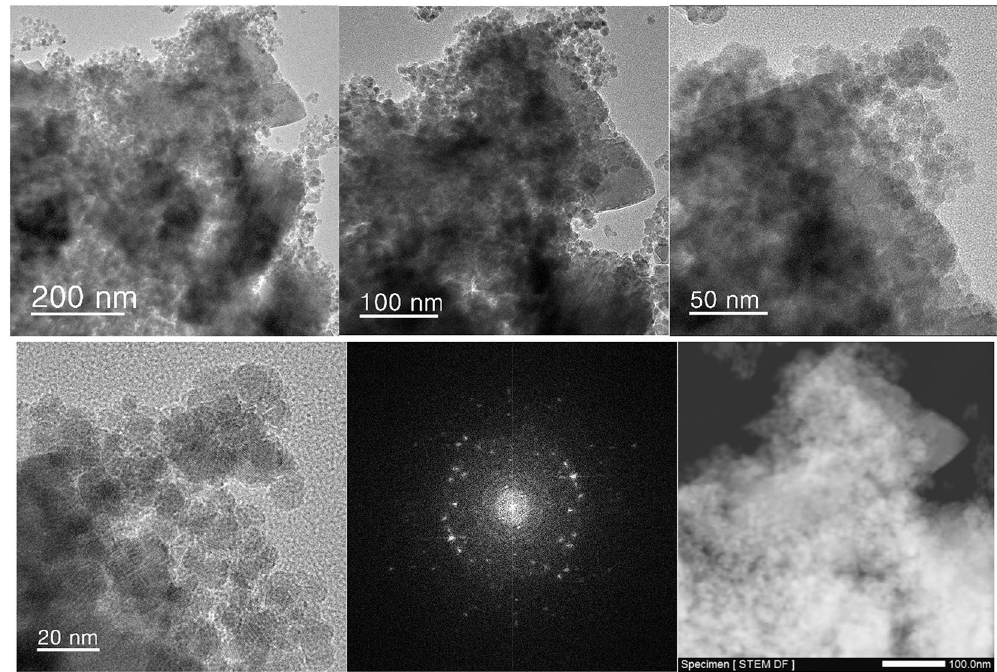
Figure 5. TEM, HRTEM, FFT and STEM images of Ps@Tet-Cu(II)@Fe 3 O 4